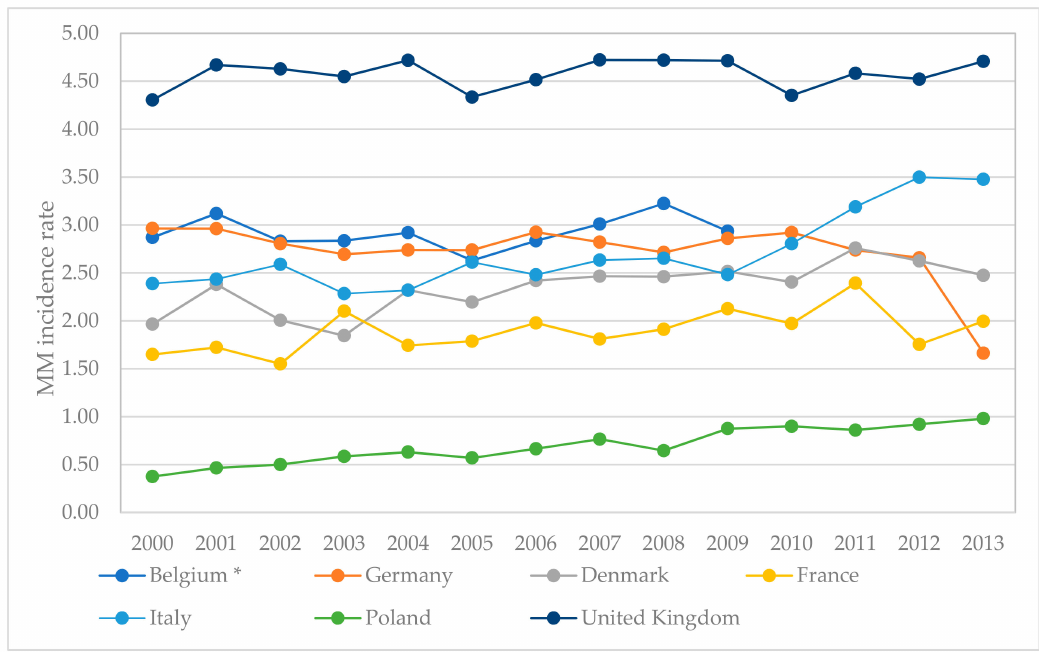
Figure 9. The MM incidence rate in selected European